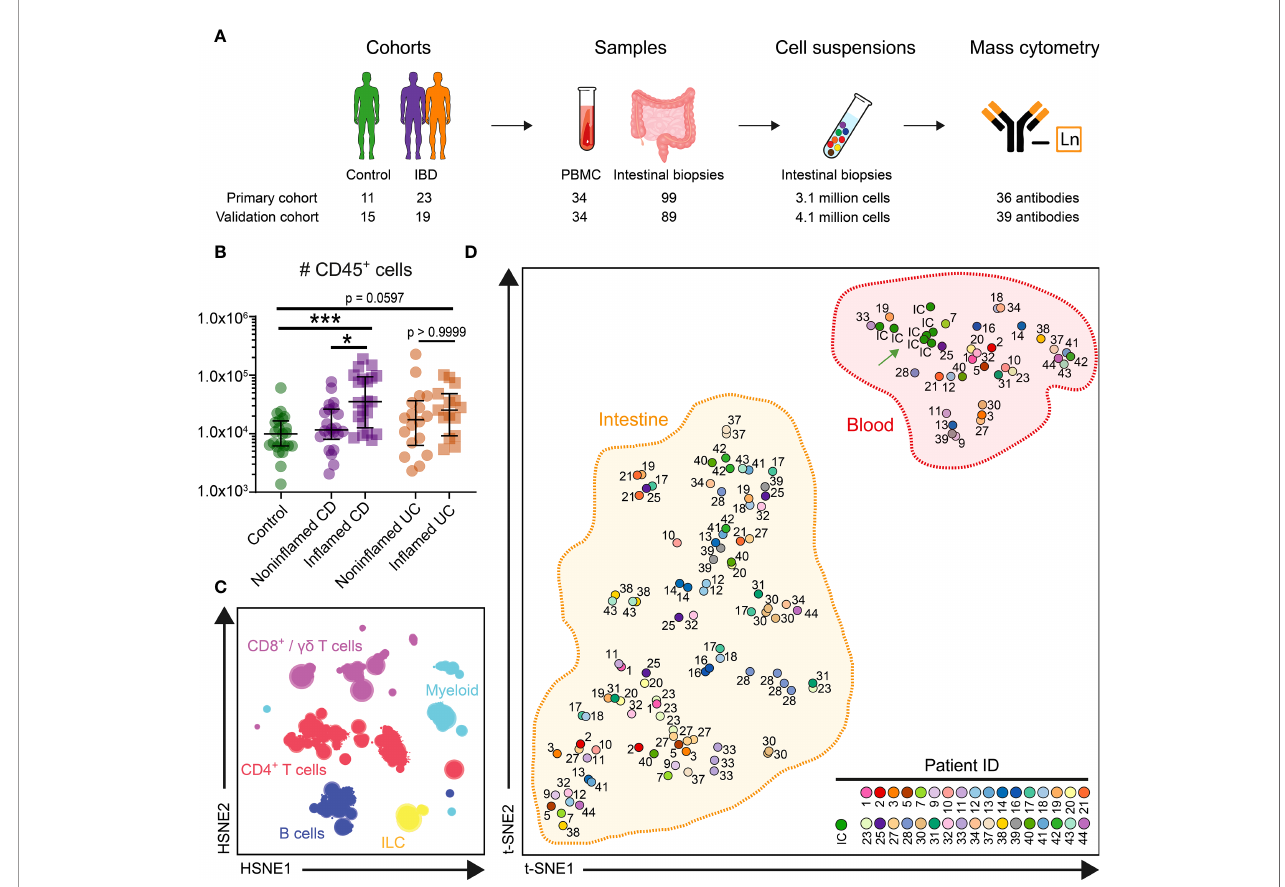
FIGURE 1 | HSNE identi fi es major immune lineages in blood and intestine. (A) Experimental approach (B) Graph showing absolute number of CD45 + immune cells acquired from 99 intestinal biopsies of the primary cohort. Bars indicate the median with interquartile range. *p ≤ 0.05, ***p ≤ 0.001, Kruskal Wallis test for multiple groups. (C) Overview HSNE embedding of 7.7 million immune cells. Color represents the major lineages. (D) t-SNE analysis (% of CD45 + cells) of clustered cells for 133 samples and 7 internal control (IC) replicate samples. Every dot represents a sample, and the color and number display 34 individuals and the IC (green arrow)